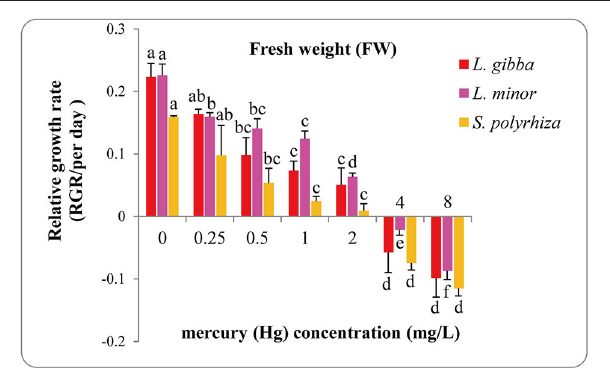
FIGURE 2 | Effects of different concentrations of Hg on the relative growth rates based on fresh weight (FW) of three duckweed lines. The letters (a, b, c, d) on the column graphs indicated Tukey tests analyses results among different Hg treatments in the same duckweed. The same letters indicated no significant differences and different letters indicated significant difference among treatments. Error bars indicated standard